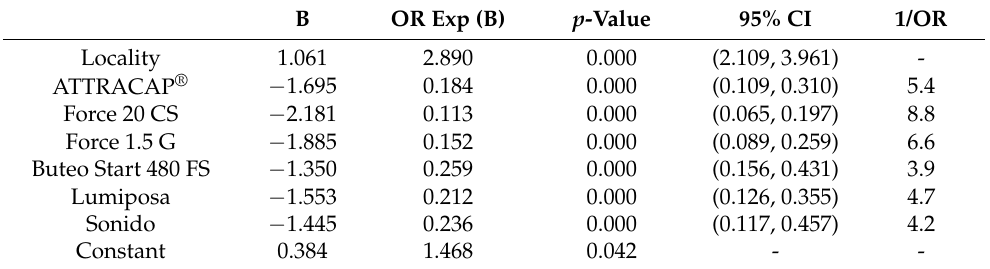
Table 6. Odds of plant damage occurrence compared to the control, depending on insecticidal treatments.